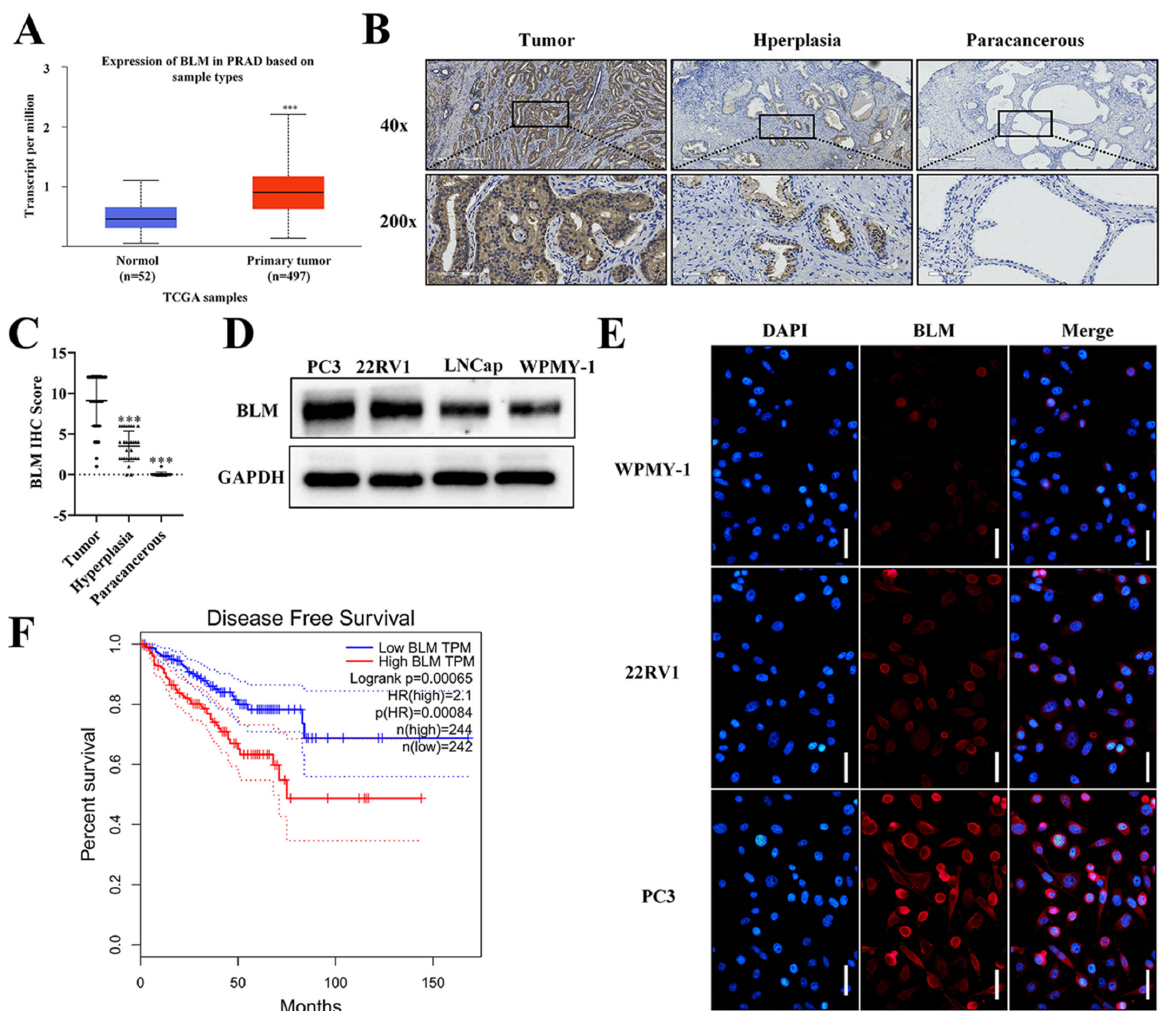
Figure 1. BLM is highly expressed in PCa and its expression correlates with poor survival. ( A ) Pros ‐ tate cancer with BLM transcripts apparently had higher expression (n = 497) than normal tissues (n = 52) from the TCGA database (*** p < 0.001). ( B ) The BLM protein level in prostate cancer tissues, hyperplasia, and paracancerous tissues were shown by immunohistochemistry (IHC) (Brown: BLM). 40X and 200X ‐ image. ( C ) BLM IHC staining scores in prostate cancer tissues (n = 60), hyper ‐ plasia tissues (n = 30), and paracancerous tissue (n = 30) are shown (*** p < 0.001). ( D ) WB analysis of the BLM protein level in prostate cell lines. ( E ) IF analysis of the BLM protein level in prostate cell lines. Scale bars: 50 μ m. ( F ) Comparison of DFS in the indicated groups. Low BLM expression group, n = 242; high BLM expression group, n = 244. Patients with high expression of BLM had a significantly worse prognosis than those with low expression of BLM ( p = 0.00065); n: number of patients.